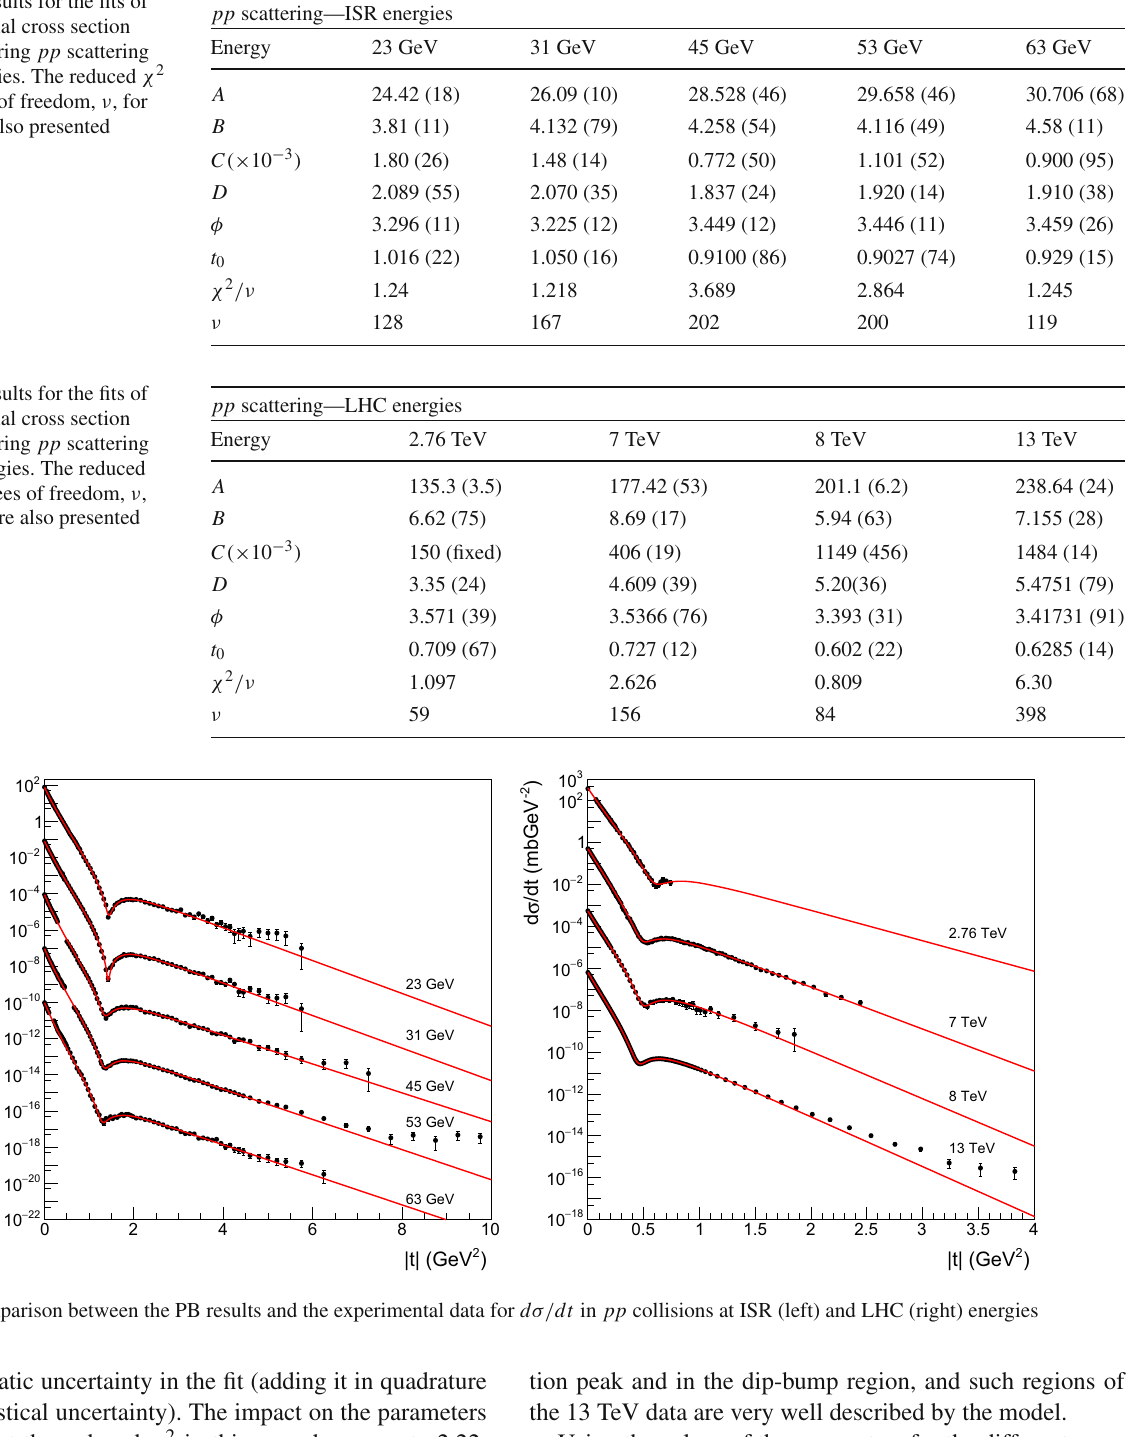
Table 1 Results for the fits of the differential cross section data considering pp scattering at ISR energies. The reduced χ 2 and degrees of freedom, ν , for